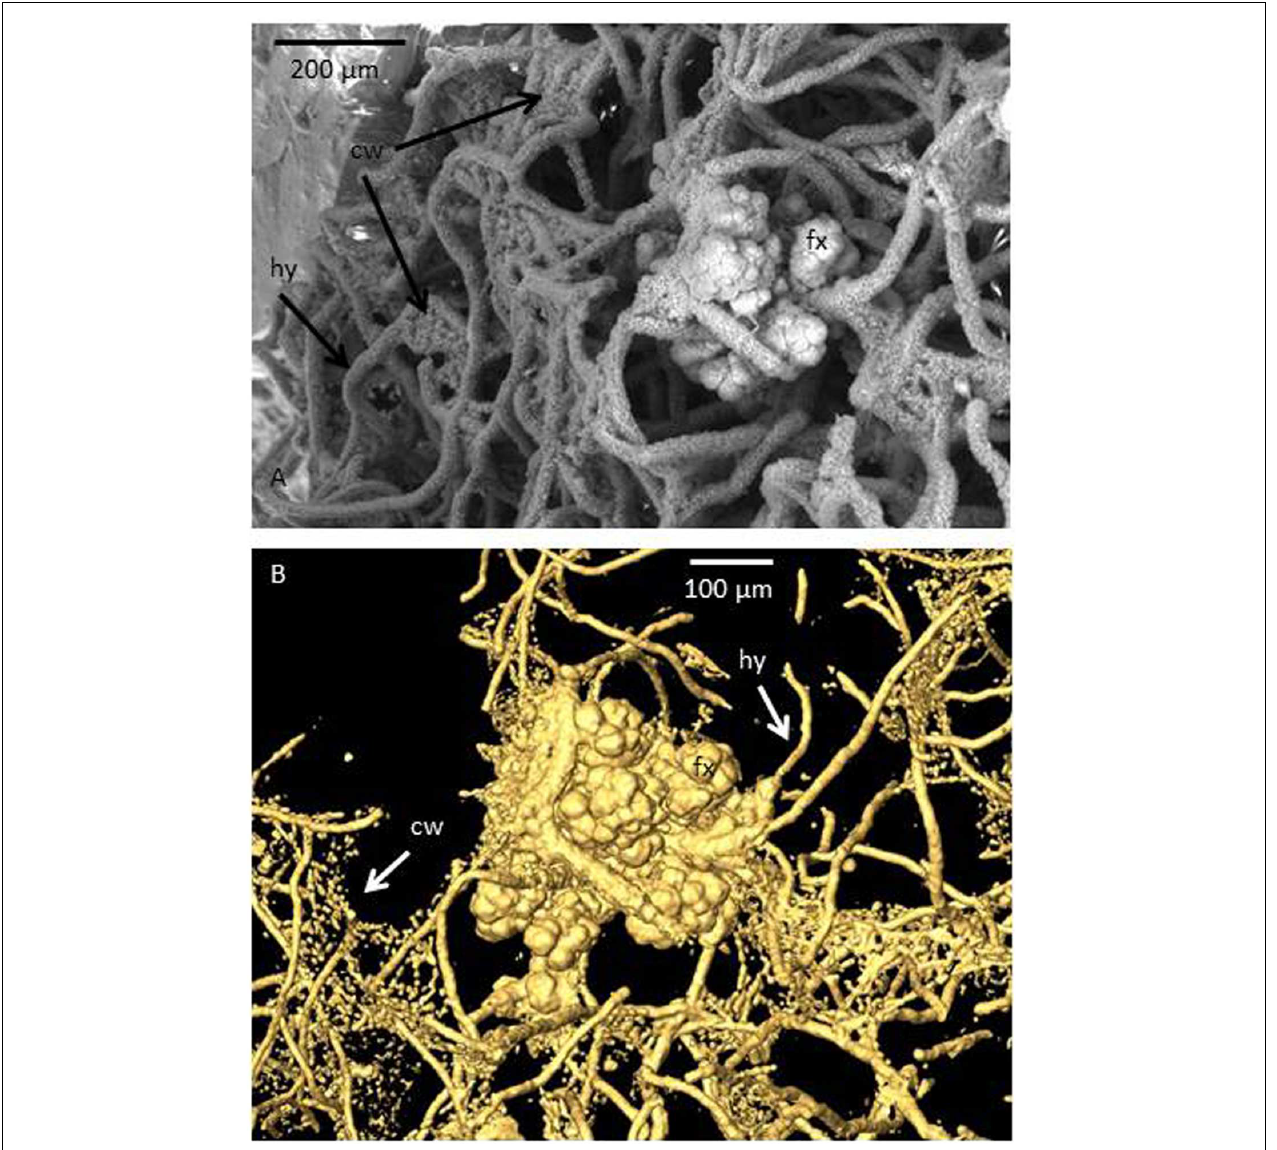
FIGURE 1 | Images showing the symbiotic relationship between fungi and chemoautotrophic prokaryotes in subseafloor basalts. The sample was collected at the Koko Seamount in the Pacific Ocean during Ocean Drilling Program 197, and represents a depth of 67.5 m below seafloor and an age of 48 Ma. (A) Environmental scanning electron microscopy (ESEM) micrograph of a fossilized fungal mycelium in a basalt vesicle. The fungal hyphae (hy) act as the framework on which prokaryotes have grown. The cauliflower-like structure represents Frutexites (fx), a microstromatolitic structure formed by iron oxidizing bacteria. In between hyphae strings of minute cells are attached in a “cobweb-like” (cw) fashion. In the ESEM image these are covered by clay and only seen as sheets compared to (B) , a tomographic reconstruction produced by synchrotron-based X-ray tomographic microscopy (SRXTM) in which the sheets become transparent and the cells organized as strings become visual. These were also interpreted as chemoautotropic prokaryotes involved in iron oxidation due to their high iron content. Thus, three types of microorganisms; one fungus and two types of prokaryotes once lived in this consortium in a close spatial interplay (Bengtson et al.,